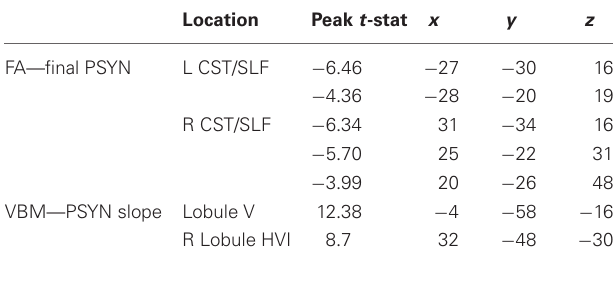
Table 1 | Coordinates and peak t -statistics for significant correlations.